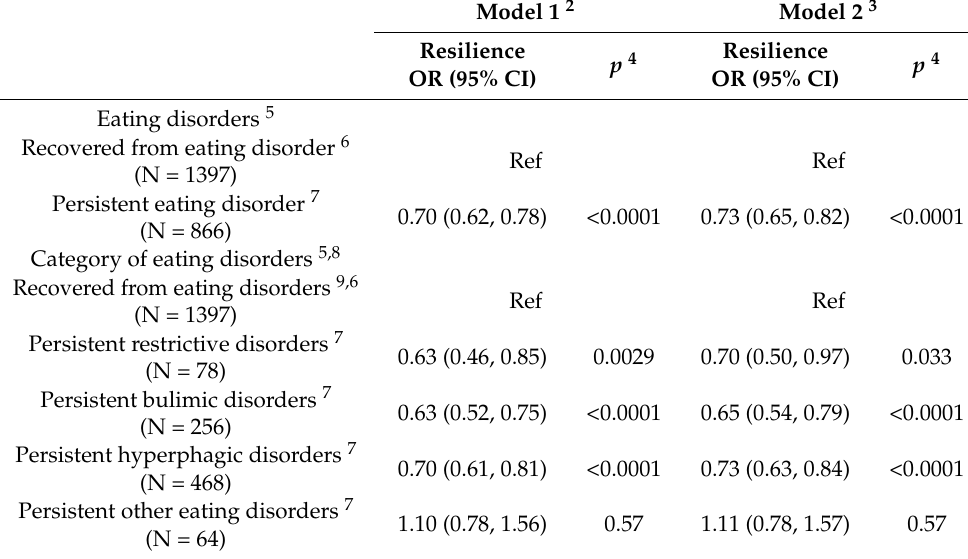
Table 4. Longitudinal associations between resilience (BRS) (independent variable) and eating disorders (EDs) (SCOFF) (dependent variable) in 2263 participants 1